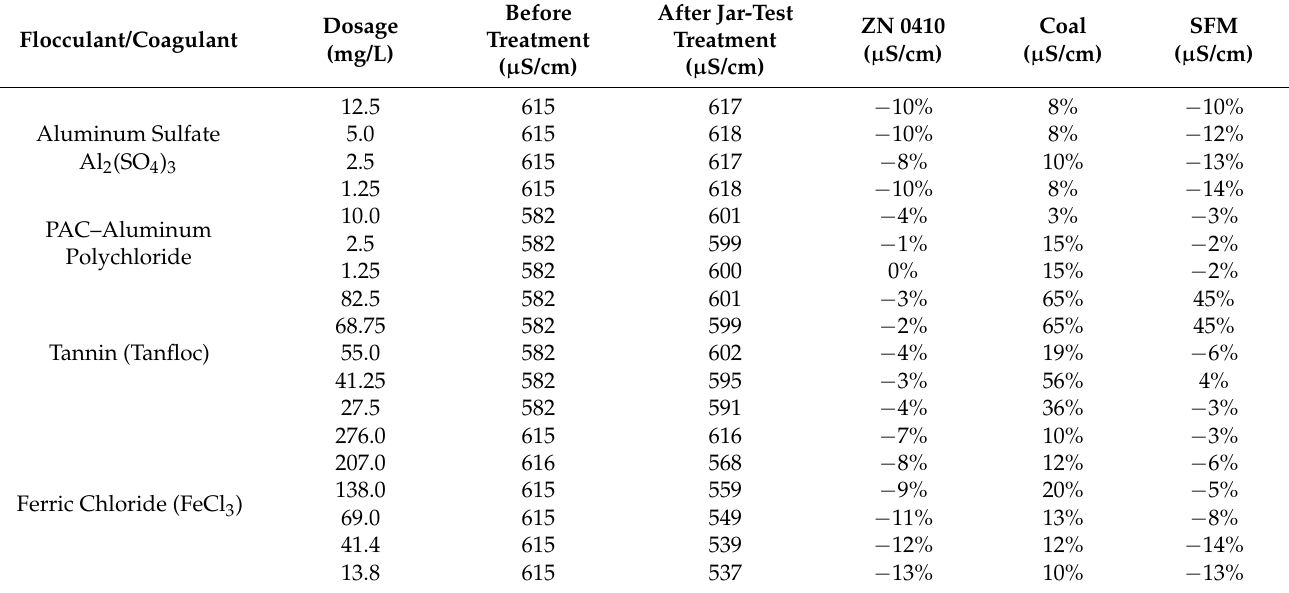
Table 1. Result of the jar tests with the evaluation of the different flocculants and zeolites and the efficiency in the removal of the SDT according to the variation of the conductivity in the coagulated and filtered